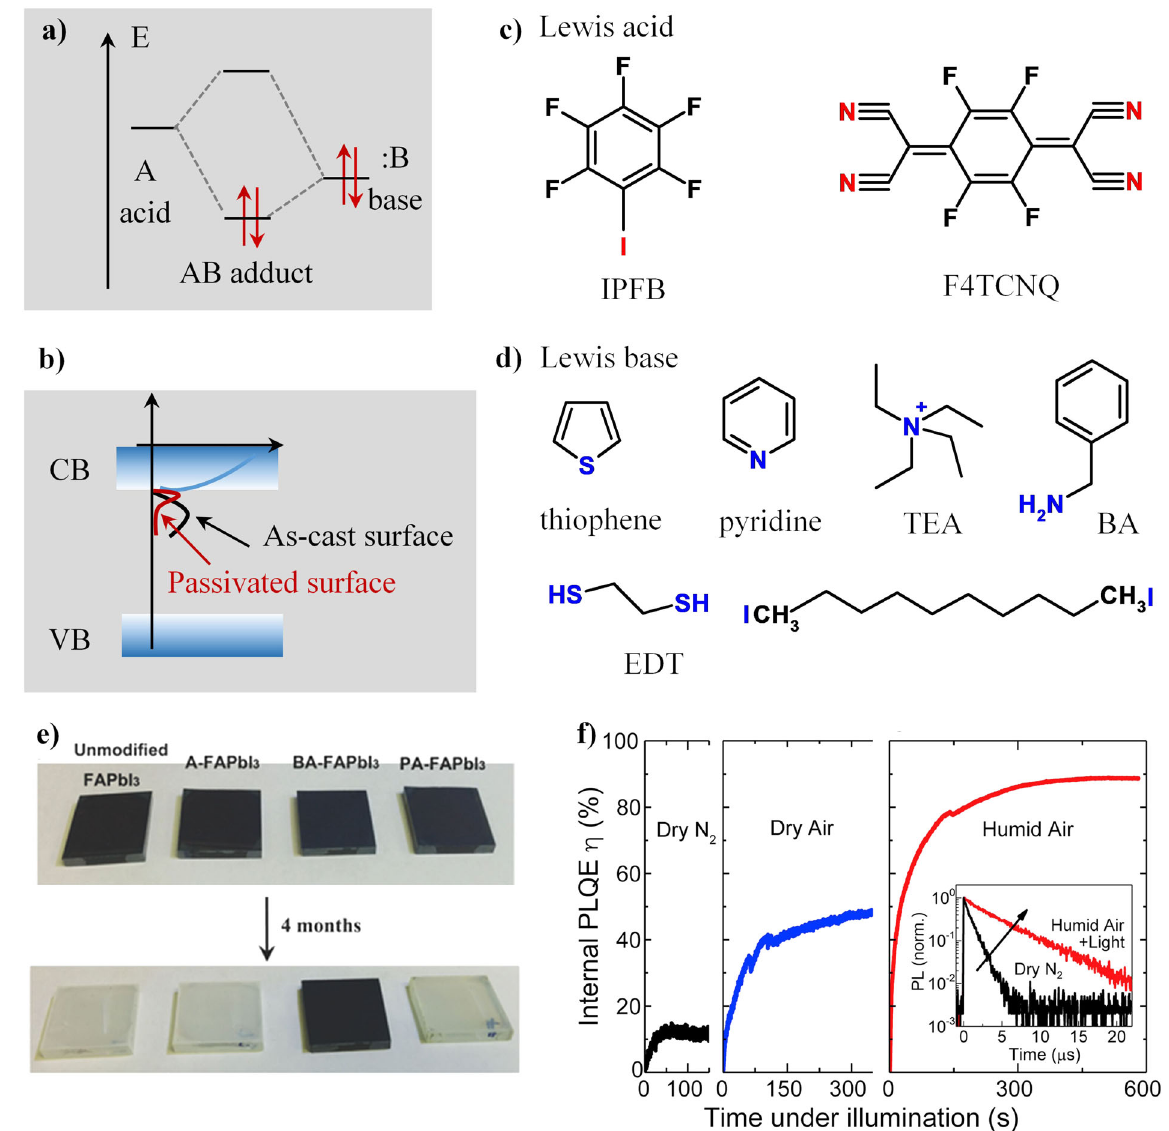
Fig. 4 Defects passivation by Lewis acid or Lewis base. a Diagram depicting the formation of a dative covalent bond between two atoms. b Diagram of the passivation of trap states. 137 c , d Chemical structures of reported small organic molecules for passivation of perovskite fi lms: c Lewis acid: IPFB (iodopenta fl uorobenzene) 103 and F4TCNQ (2,3,5,6-tetra fl uoro-7,7,8,8-tetracyano-quinodimethane). 104 d Lewis base: thiophene, pyridine, 65 TEA (tetra-ethyl ammonium), 114 BA (benzylamine), 66 EDT (1,2-ethanedithiol). 106 e Images of unmodi fi ed FAPbI 3 , A- FAPbI 3 , BA-FAPbI 3 , and PA-FAPbI 3 fi lms after 4 months ’ exposure under 50 ± 5 RH% air. 66 f Internal PLQE measurements over time under illumination in dry N 2 , dry air, and humid air. Inset: Time-resolved PL decays of the fi lms after the stated treatment with pulsed excitation at 405 nm.